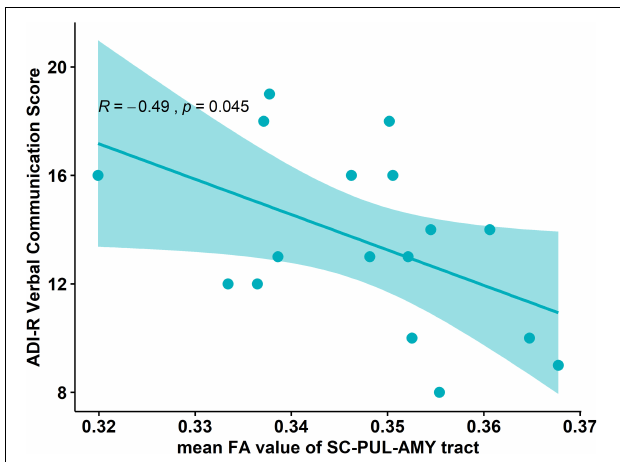
FIGURE 2 | Correlation plot between the mean FA value and the behavior scores in the ASD group. Negative correlation between the mean FA value of the tract and the ADI-R verbal communication score ( R = –0.49, p =